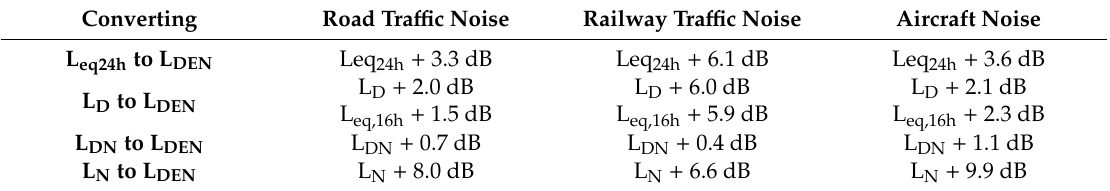
Table 2. Converting to L DEN according to Brink et al.